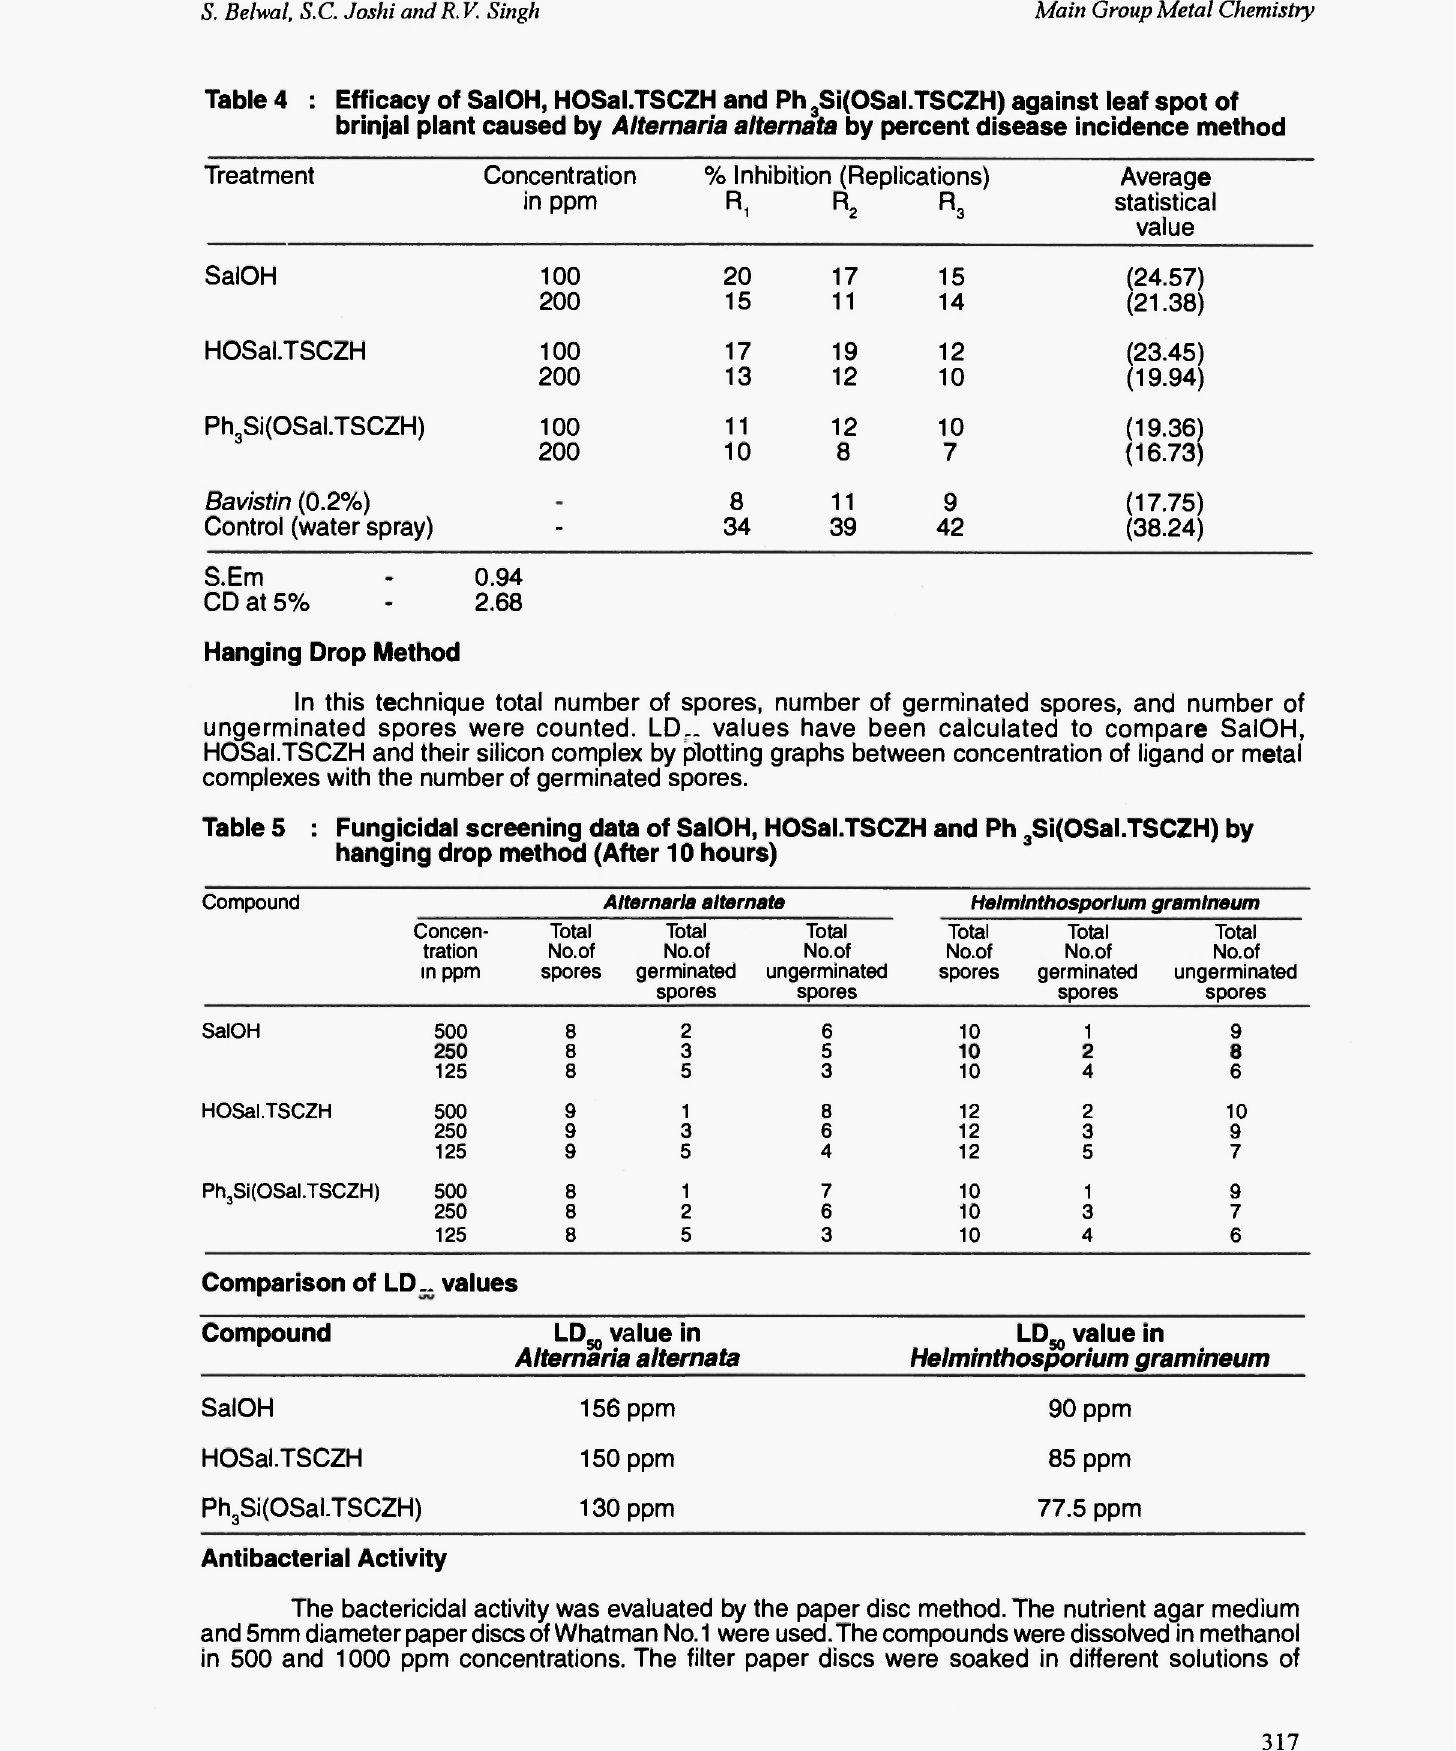
Table 4 : Efficacy of SalOH, HOSal.TSCZH and Ph brinjal plant caused by Alternaria alternate by percent disease incidence method Treatment